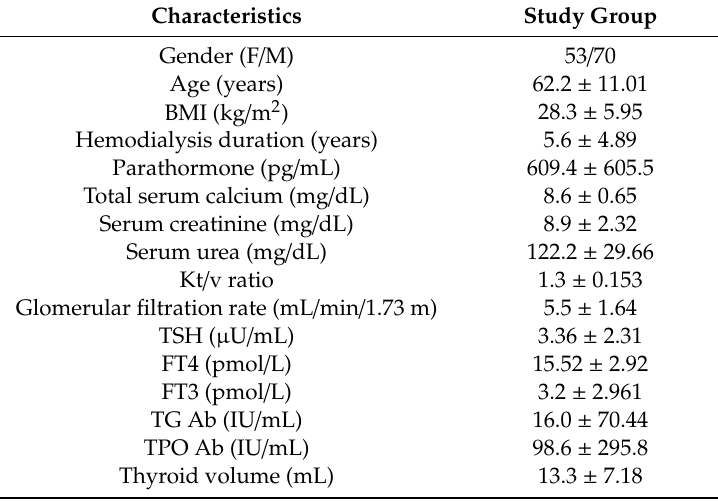
Table 1. Characteristic parameters of the study